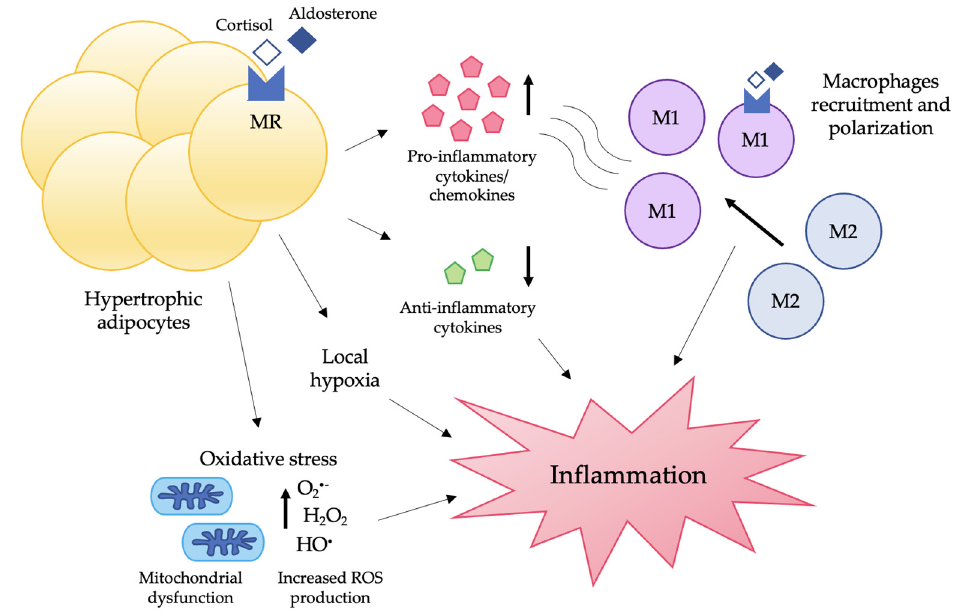
Figure 2. Contribution of MR to adipose tissue inflammation. The activation of MR, either by aldosterone or by cortisol, leads to adipocyte hypertrophy, which in turn causes cell stress and death and local hypoxia. Moreover, hypertrophic adipocytes display an impaired secretion of adipokines, with an increased release of pro-inflammatory molecules. These changes promote the infiltration of macrophages and their polarization shift to a M1 phenotype. Finally, MR activation is linked to mitochondrial dysfunction and enhanced ROS production, which contribute to oxidative stress, another important pro-inflammatory stimulus. Abbreviations: MR, mineralocorticoid receptor; ROS: reactive oxygen species.